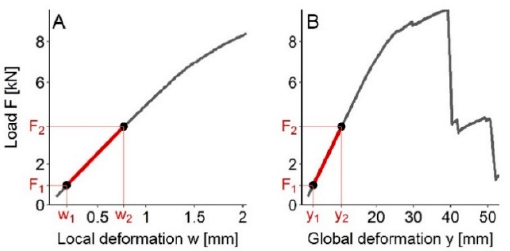
Figure 3. Load-deformation curves showing values used for estimation of local ( A ) and global ( B ) modulus of elasticity. F 1 and F 2 represent applied load calculated as 10% and 40% of the maximum load, respectively, and w i and y i are local and global deformations corresponding to F i , respectively.